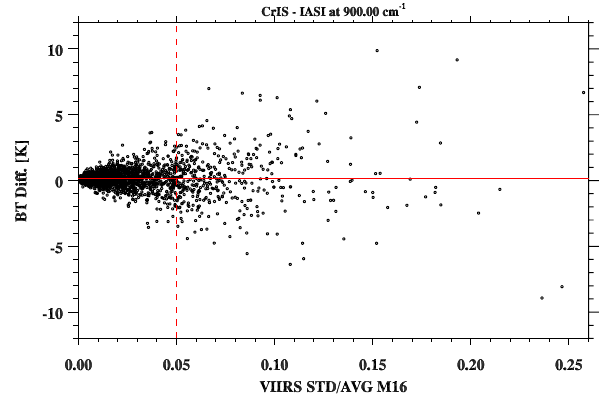
Figure 5. BT difference at 900cm − 1 between CrIS and IASI/B vs. the standard deviation to mean ratio of the VIIRS radiances in band M16. The horizontal line indicates the mean of CrIS–IASI BT dif- ferences with a value of 0.158K and the standard deviation of BT differences is